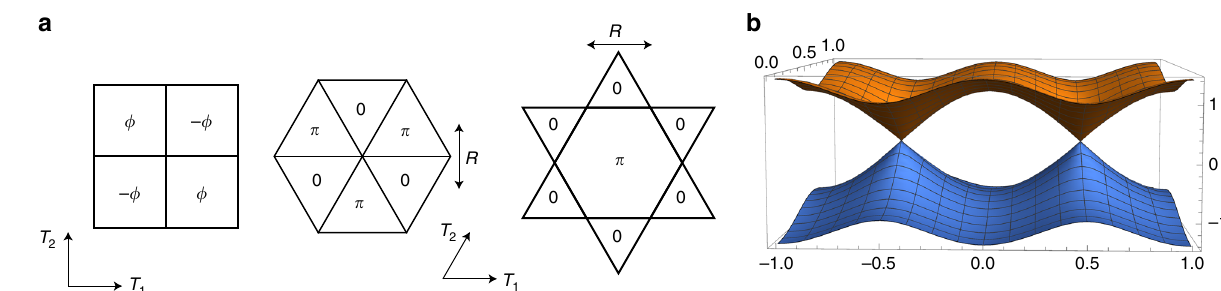
Fig. 1 Mean- fi eld ansatz and band structure. a Mean- fi eld ansatz of Dirac spin liquid on the square, triangular, and kagome lattice. Mean- fi eld Hamiltonian has only nearest hopping with a fl ux in each plaquette. b Band structure of the square lattice π - fl ux mean fi eld ansatz with two Dirac cones at the momentum points ( k 1 , k 2 ) = (± π /2,